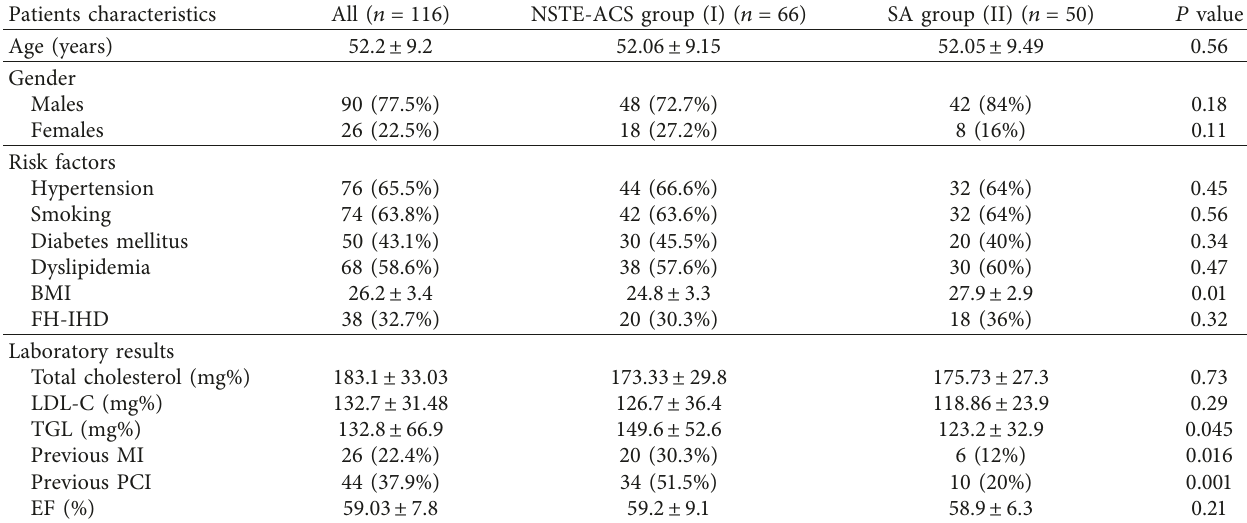
Table 1: Demographic and clinical data of stable angina and NSTE-ACS groups.